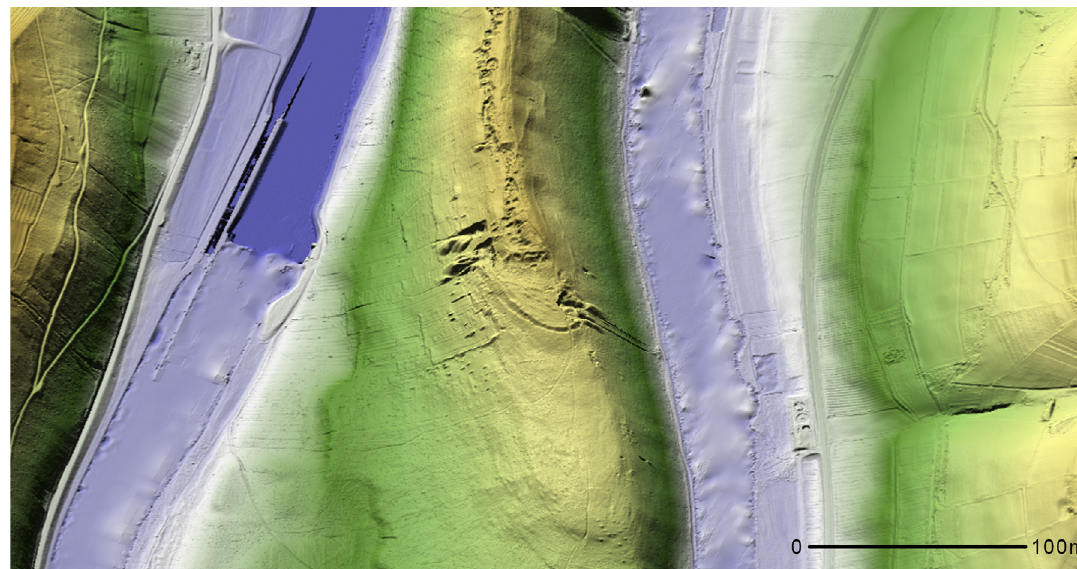
Figure 11. Three-dimensional terrain model of the Wettenburg hill fort at the Main River bend near Urphar. In the middle, sections of fortified walls are quite clear in the interpolated elevation model. Legend: blue−green−yellow−brown = from 138 meters (alti- tude above mean sea level) at river Main up to 234,19 meters at the highest point of the plateau. Source: see Fig. 5, GIS